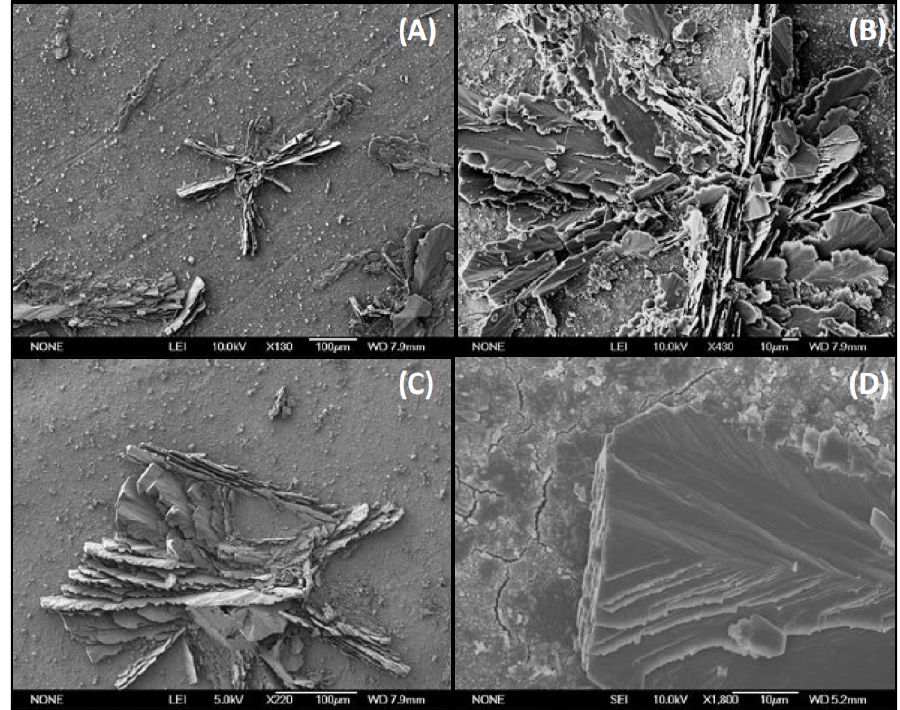
Figure A1. EDS spectra of MMS membrane fouled/scaled after 14 h of filtration with raw water treatment (Figure 4) that includes UF (configuration B, Figure 2). The presence of calcium and sulfur are consistent with the presence of calcium sulfate as also suggested by the gypsum (calcium sulfate dihydrate) rosette-type crystal structures. The presence of calcium and oxygen are consistent with the expected presence of calcite given the supersaturation of the raw feedwater with respect to calcite (Table 1). Note: Au peak is present since the membrane sample was coated with gold (Au) prior to EDS analysis.